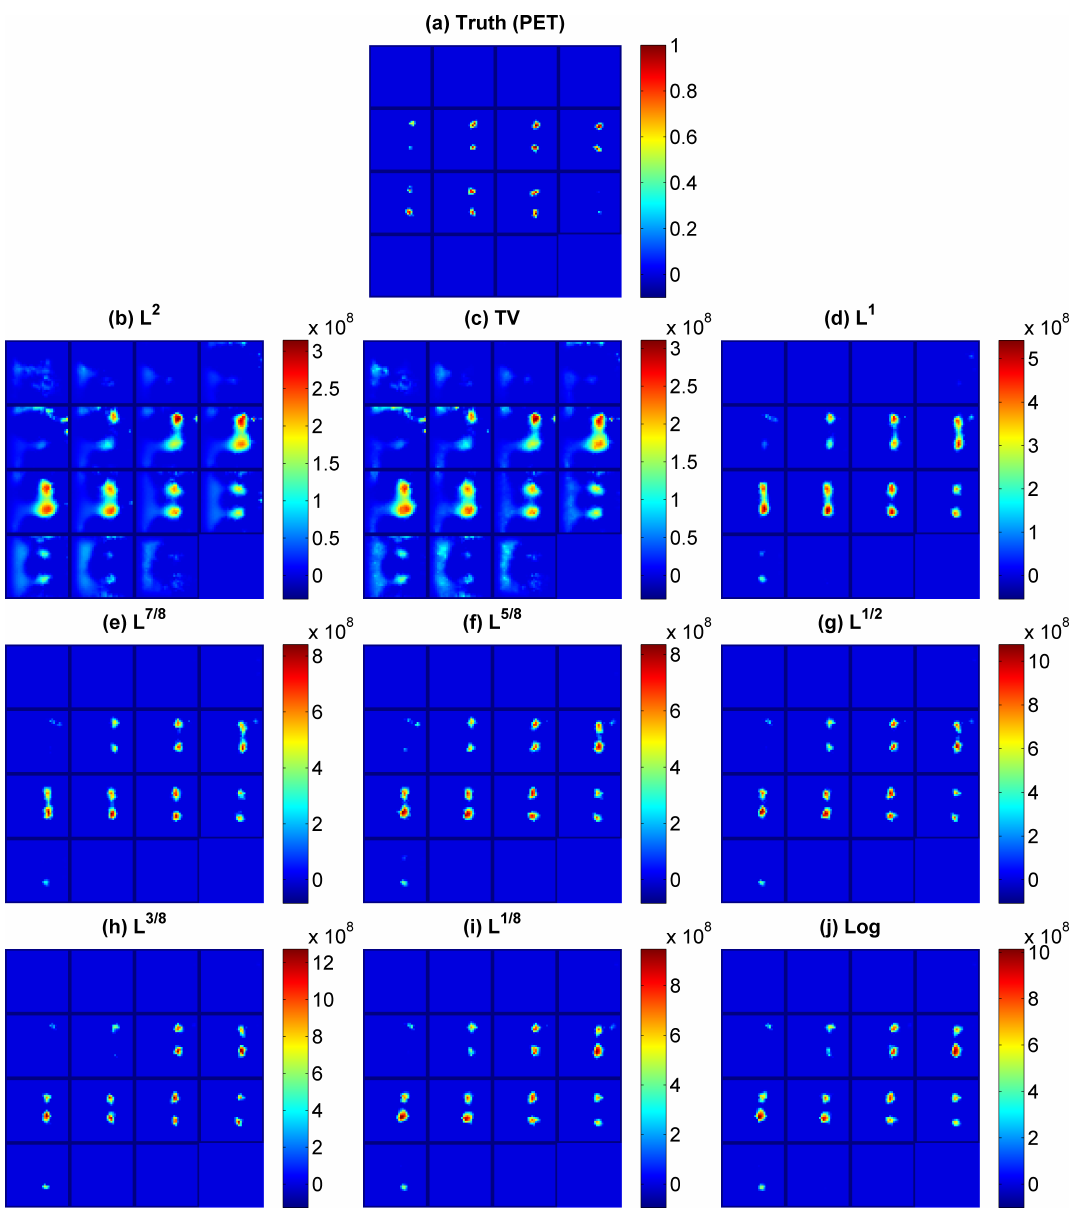
Figure 3. Cubic phantom with two small rods as target: coronal sections of the phantom showing ( a ) PET result as truth, and reconstruction results using regularizations based on: = 1.0E-6, ( c ) T V with λ = 3.0E-9, ( d ) L 1 with λ = 9.0E+3, ( e ) L 7 / 8 ( b ) L 2 with λ 2 TV 1 = 1.0E+5, ( f ) L 5 / 8 with λ = 4.0E+6, ( g ) L 1 / 2 with λ = 5.0E+7, ( h ) L 3 / 8 with with λ 7 / 8 5 / 8 1 / 2 λ = 6.0E+8, ( i ) L 1 / 8 with λ = 1.0E+10, and ( j ) Log with λ = 9.0E+11, log 3 / 8 1 / 8